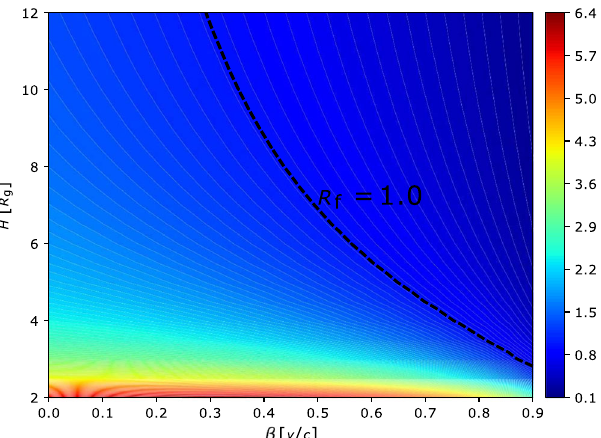
Fig. 4 The dependence of the re fl ection fraction on the corona height and the bulk velocity. The dimensionless re fl ection fraction R f , is estimated as a function of the corona height H (in units of R g ) and the bulk velocity β = υ / c . The dashed line corresponds to the re fl ection fraction R color bar represents the dimensionless re fl ection fraction, with the minimum and maximum being 0.1 and 6.4,